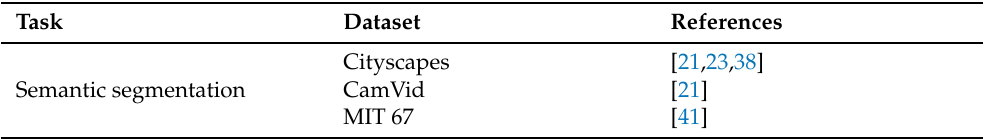
Table 7. References presented by the used datasets. Private or non-specified datasets are not presented